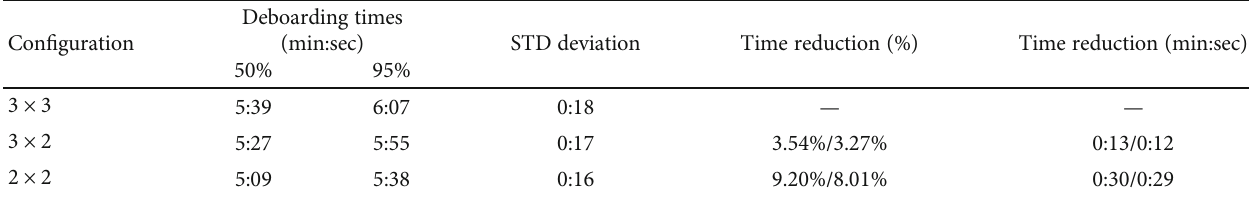
Table 4: Comparison of deboarding times for the three aircraft con fi gurations.